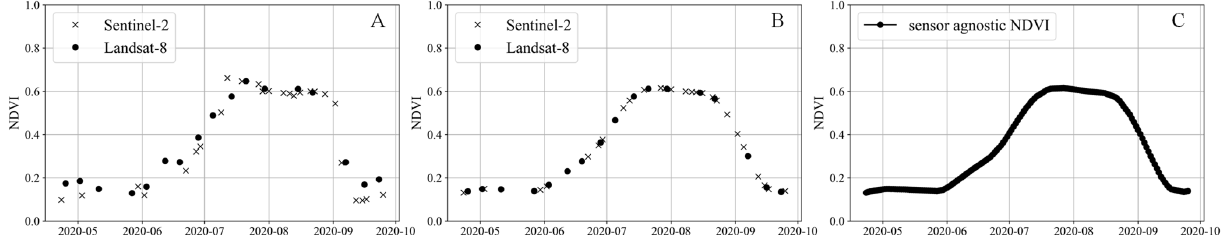
Figure 4. A schematic illustration of steps #4 and #5. ( A ) shows the average NDVI from Sentinel-2 and Landsat-8 for a given field, with 43 data points; ( B ) displays the data points ( n = 43) after LWR; and ( C ) depicts the results after the interpolation (linear line between the adjacent points) and the increase in data points ( n = 156).